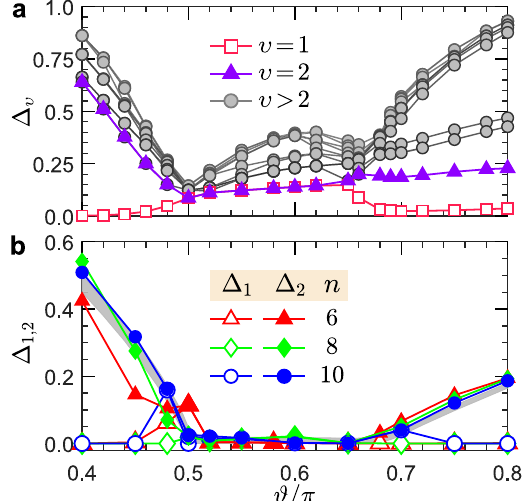
Fig. 6 Excitation gaps. a The fi rst fi fteen excitation gaps Δ υ with degeneracy for a N = 24 hexagonal cluster. The zigzag and stripy phases are doubly degenerate while the ground state of the QSL in the middle is unique. b The two lowest excitation gaps Δ 1 (open symbols) and Δ 2 ( fi lled symbols) at three XC clusters where the circumferences n are 6 (red triangle), 8 (green diamond), and 10 (blue circle). The thick belt is the extrapolated bulk